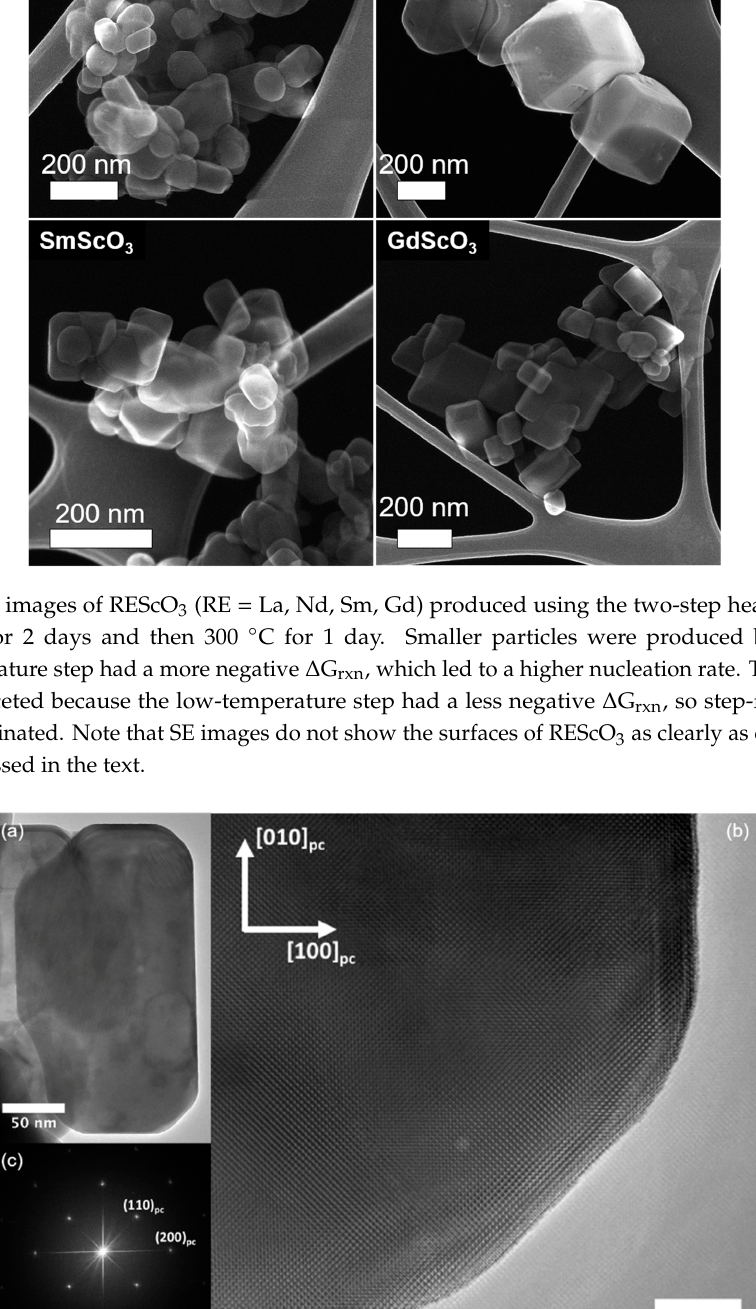
Figure 5. ( a ) Low magnification HREM image of a faceted NdScO 3 particle produced using the two- step heat treatment at 450 °C for 2 days and then 300 °C for 1 day. ( b ) Enlarged HREM image of the lower-right corner of the nanoparticle. ( c ) Corresponding power spectrum of the entire particle indexed to show that it is terminated with the pseudo-cubic {100} and {110} surfaces.